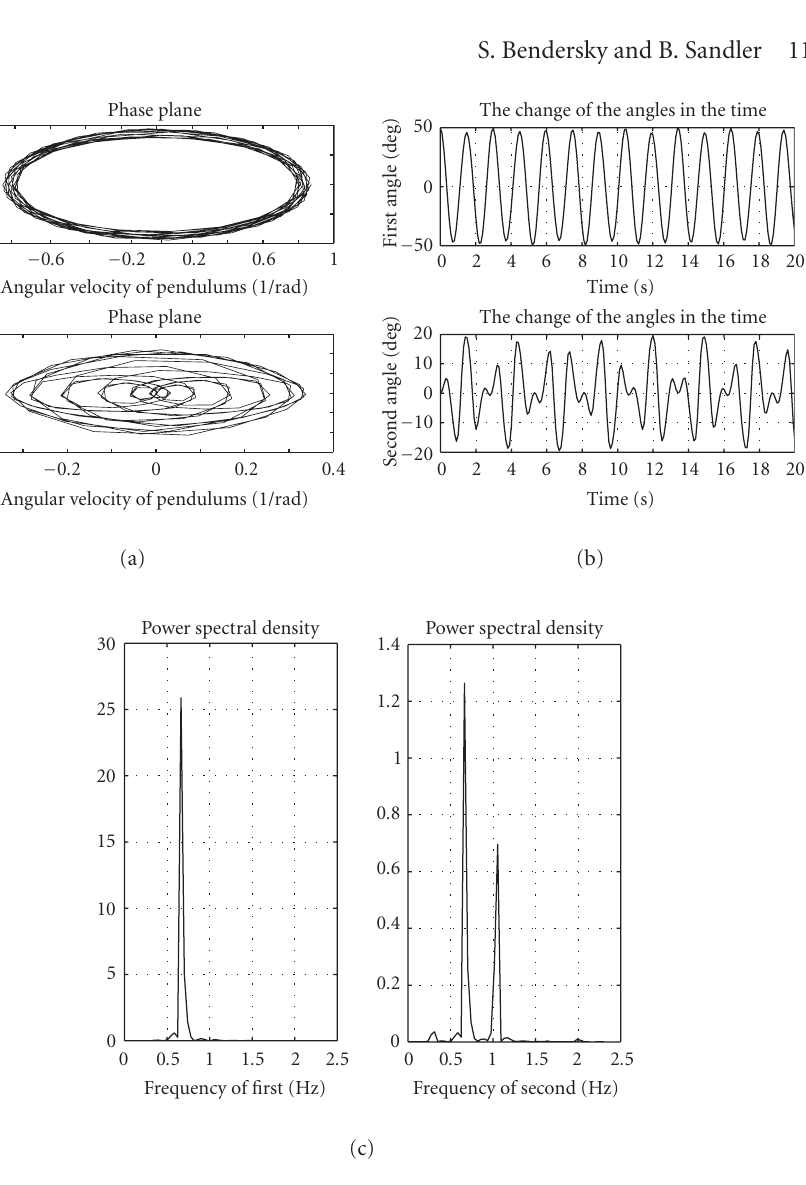
Figure 3.4. (a) “Phase portraits” for the two pendulums; (b) swinging angles ϕ 1 ( t ) and ϕ 2 ( t ); (c) oscillation spectrum distributions for the two pendulums. Parameters are m 1 = m 2 = 1 . 57 kg, L 1 = L 2 = 0 . 3 m, Ψ = 60 ◦ . Initial conditions are ϕ 1 = 50 ◦ , ϕ 2 = 0 ◦